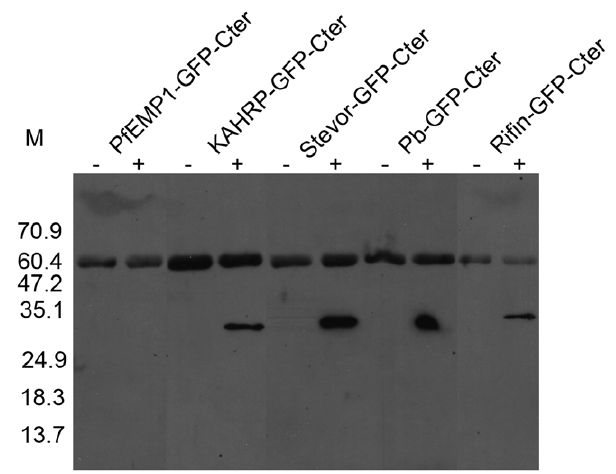
Figure 5. Export of GFP to the erythrocyte surface. Live trophozoite-infected erythrocytes expressing GFP reporter proteins with the PfEMP1 C-terminus at the carboxy terminus and the N- terminus of PfEMP1 (PfEMP1-GFP-Cter), KAHRP (KAHRP-GFP-Cter), stevor (Stevor-GFP-Cter), a predicted P. berghei exported protein (Pb- GFP-Cter), or rifin (Rifin-GFP-Cter) were incubated with ( + ) or without ( 2 ) TEV protease. Digestion samples were centrifuged, and superna- tants were immunoprecipitated with protein-A agarose-coupled rabbit anti-GFP antibodies. The immunoprecipitates were processed for western blotting. The predicted sizes of full-length proteins in each case are . 85 kDa and of the TEV cleaved products < 30 kDa (36 kDa for PfEMP1-GFP-Cter). The presence of signal at < 30 kDa in protease- containing samples indicates export of GFP to the surface of infected erythrocytes. The larger band ( < 60 kDa) is likely due to cross reactivity of secondary antibodies with the heavy chain of rabbit anti-GFP antibodies used for immunoprecipitation. No larger signals indicating the presence of unprocessed proteins were seen.